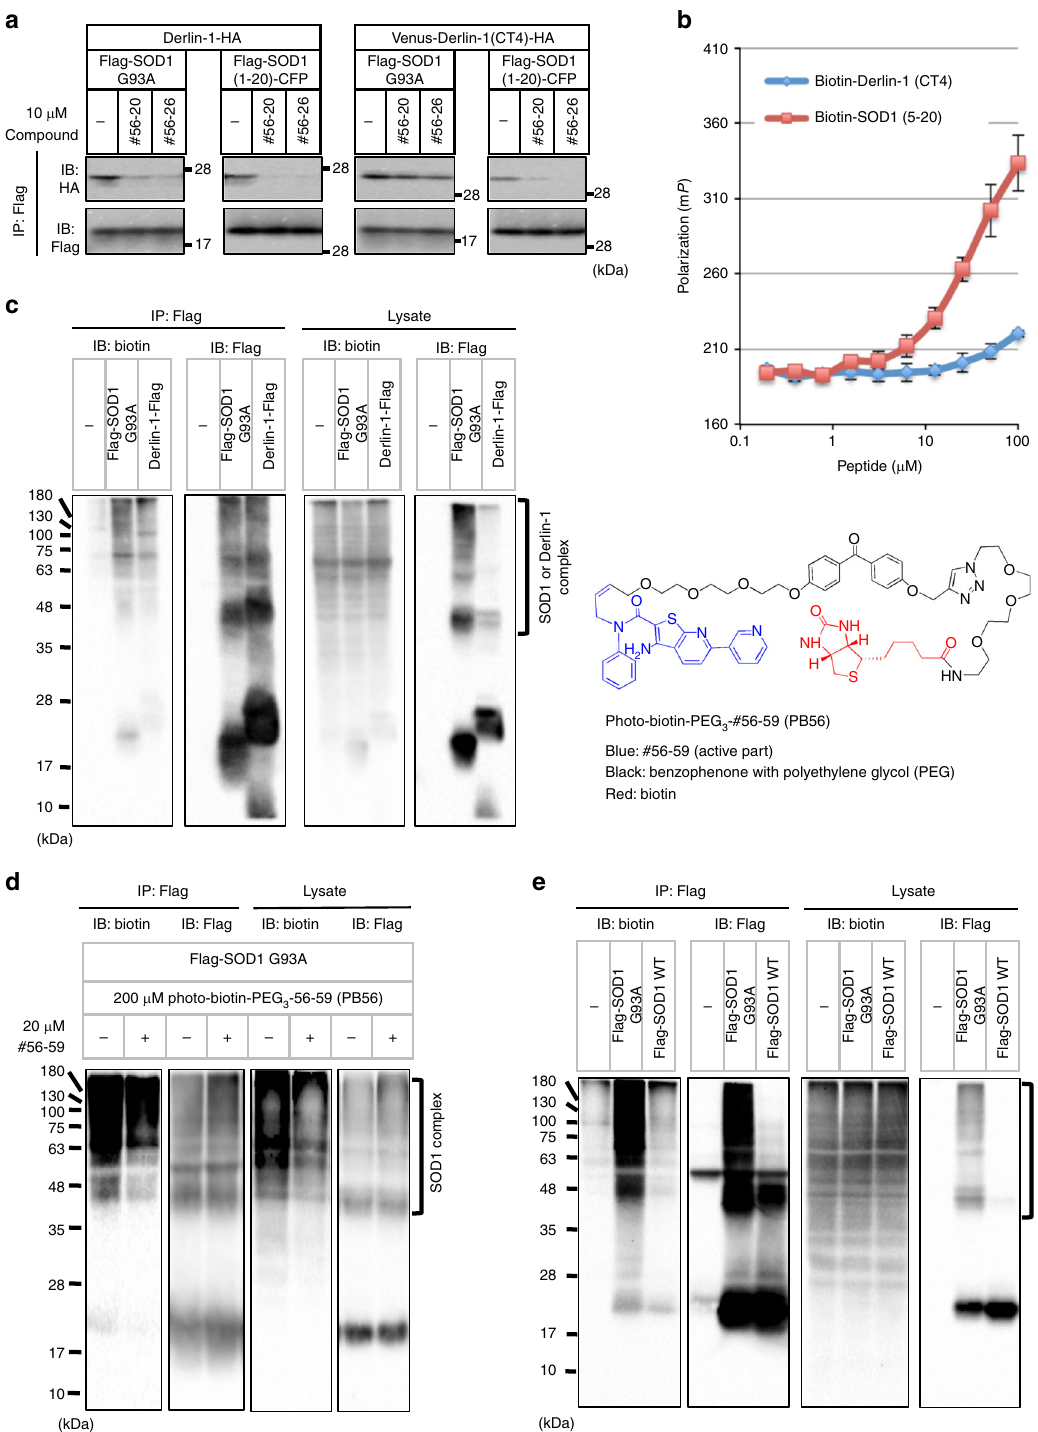
Fig. 4 #56 analogs target SOD1 DBR. a In vitro IP assay with various SOD1-Derlin-1 complexes. SOD1-Derlin-1 complexes puri fi ed from lysates transfected with the indicated plasmids were incubated with #56-20 or #56-26 for 16 h and analyzed by IP-IB with the indicated antibodies. b FP analysis of #56-20 in the presence of indicated concentration of SOD1 (5-20) and Derlin-1 (CT4) peptide. Here, 250 nM #56-20 was incubated with the indicated concentration of each peptide for 6 h, and FP was measured. Blue: Derlin-1 (CT4); red: SOD1 (5-20). The data are shown as the mean ± s.d. ( n = 3). c – e Pull-down assay using PB56. HEK293A cells transfected with indicated plasmid were treated with 200 μ M PB56 for 24 h followed by UV light irradiation for 1 h. Lysates were analyzed by IP-IB with the indicated antibodies. c Pull-down assay by Flag-SOD1 G93A or Derlin-1-Flag. Chemical structure shows PB56 (blue: #56-59 (active part); black: benzophenone with polyethylene glycol (PEG) as spacers; red: biotin). d Competition assay with the pre-treatment of 20 μ M #56-59 for 12 h. e Pull-down assay by Flag-SOD1 G93A or Flag-SOD1 WT